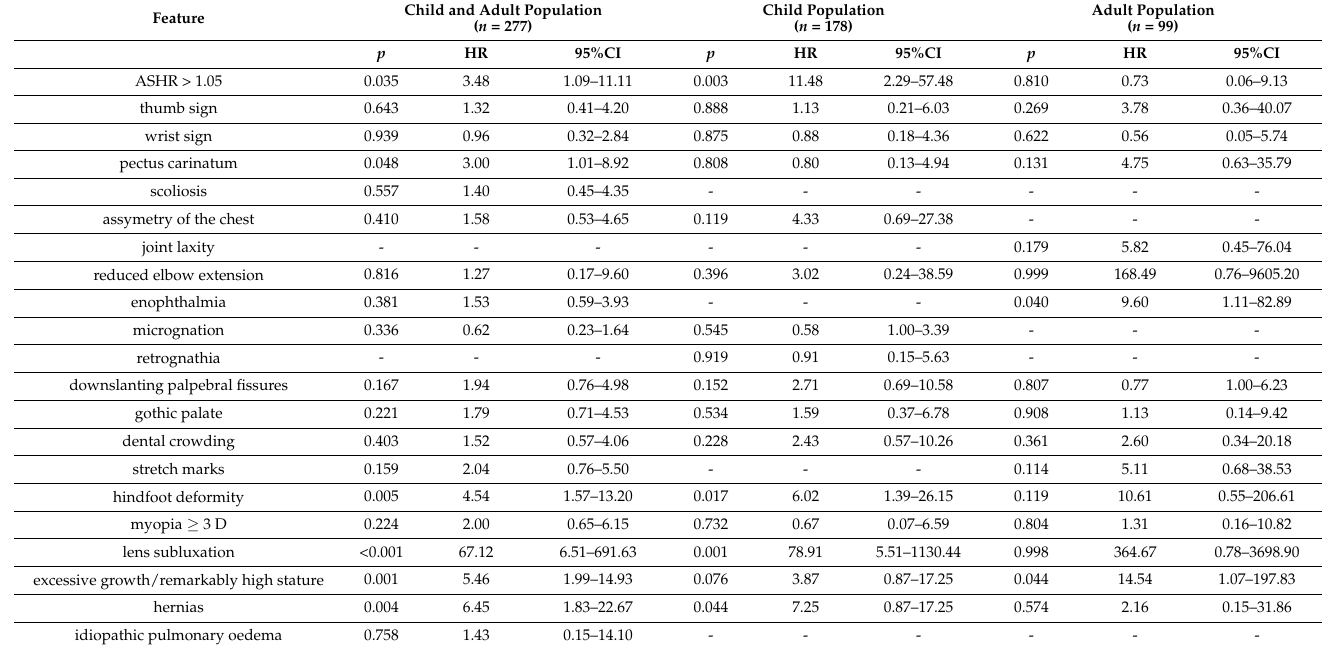
Table 3. Multivariate logistic analysis in order to establish independent predictors for the diagnosis of